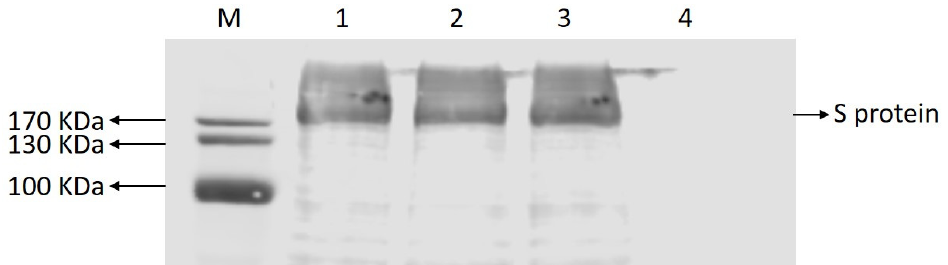
Figure 3. Identification of mAb 5F7 to the PEDV S protein expressed in Vero E6 cells in Western blot analysis. Lane M, protein marker. The Vero E6 cells in lane 1 were transfected with pcDNA3.1( − )– LNCT2–S, expressing the PEDV S protein, whereas the Vero E6 cells in lanes 2 and 3 were infected with PEDV CV777 and LNCT2. Vere E6 cells were used as negative controls (Lane 4). mAb 5F7 reacted well with the PEDV S protein expressed in Vero E6 cells and the S protein of PEDV CV777 and LNCT2. The mAb 5F7 did not react with the Vero E6 cells.